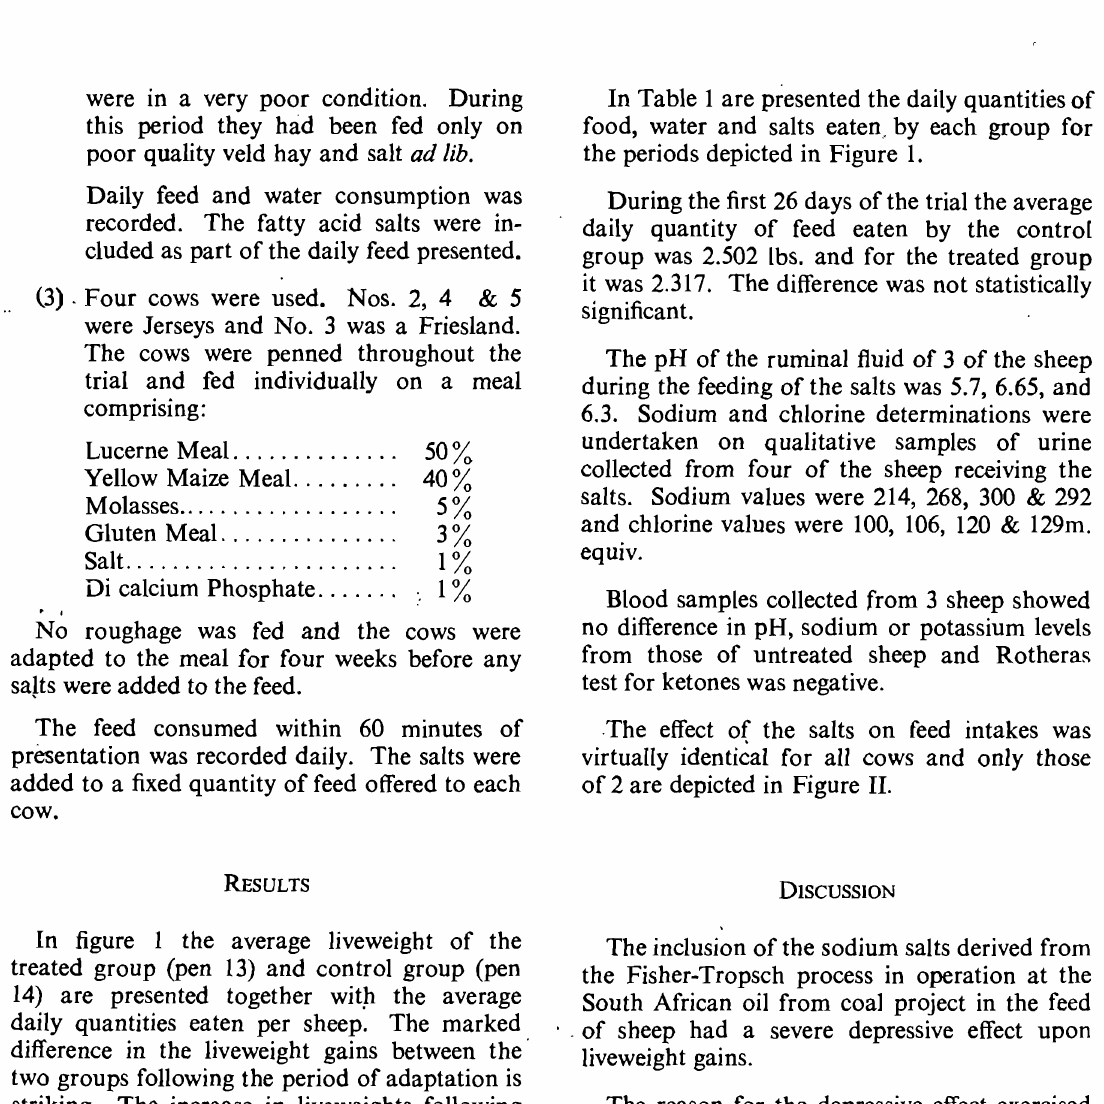
Average quantity of feed eaten in